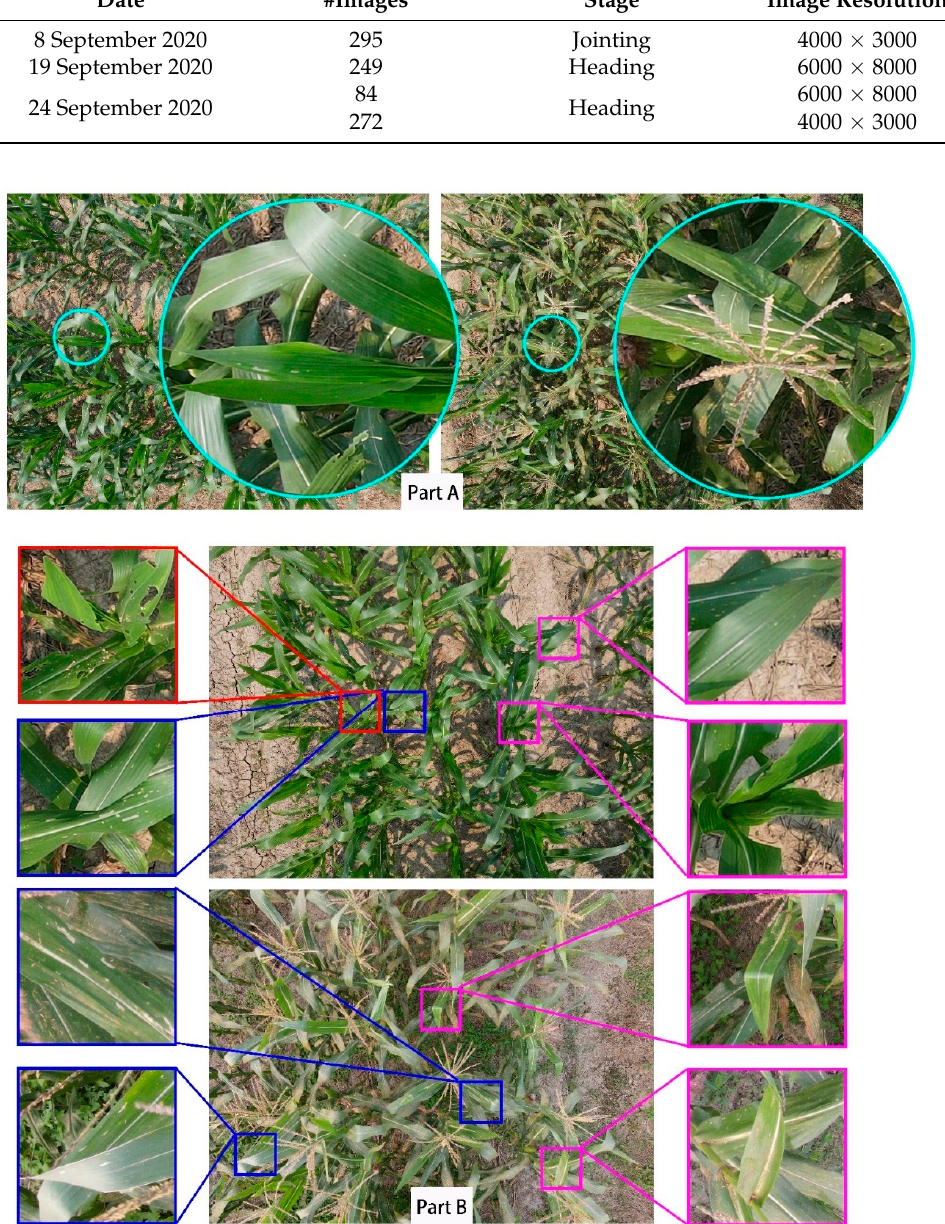
Figure 2. ( Part A ) The picture on the left shows corn in the jointing stage, the right picture shows corn in the heading stage; ( Part B ) The red box shows severely infected corn leaves, the blue box shows slightly infected corn leaves, and the purple boxes show corn leaves in healthy